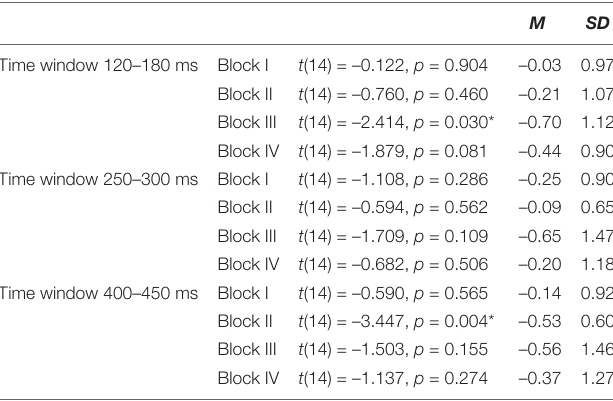
TABLE 1 | Results of one-sample t tests where the amplitudes of deviant-minus-standard subtractions were tested against